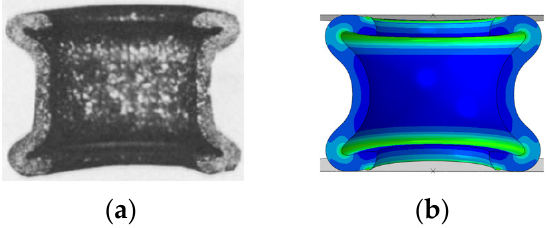
Figure 4. Comparison of ( a ) the result of the experiment [35] with ( b ) the result of the simulation for the verification of procedure in ABAQUS.